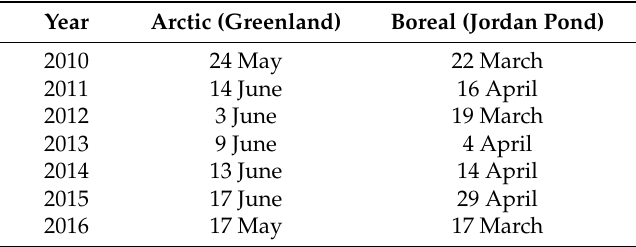
Table A1. Ice-out dates from 2010 to 2016 for the Arctic lakes and the boreal lake. Ice-out is defined as the first date that the lake is completely